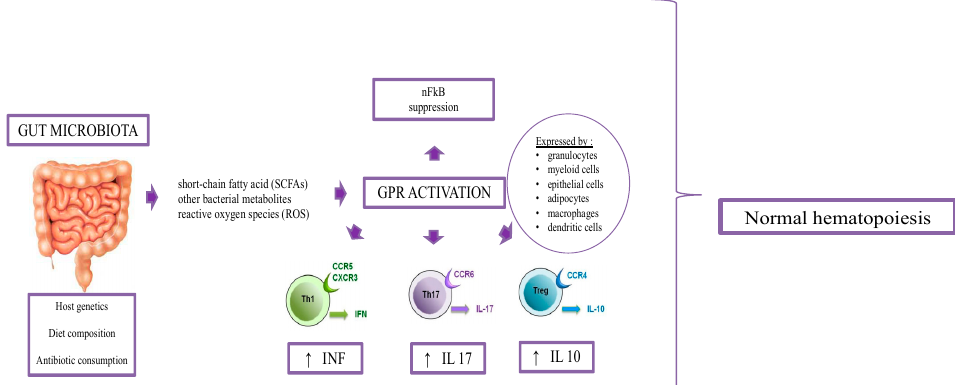
Figure 1. Gut microbiome composition in hematopoiesis. SCFAs activates several G-protein-coupled cell surface receptors, such as GPR43, GPR109a and C4, expressed by granulocytes, some myeloid cells epithelial cells, adipocytes, macrophages, and dendritic cells. SCFAs are responsible for promoting the generation of Th1, Th17, and IL-10+ cells and for decreasing the proliferation of T and 199 B cells. 200